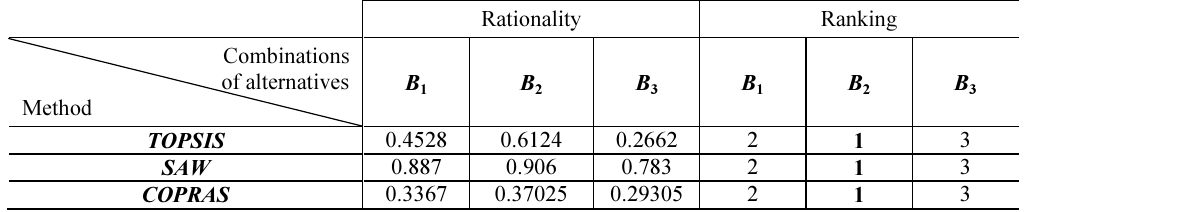
Table 8. The significance of attributes applying the expert method Types of the attributes Structure Technology